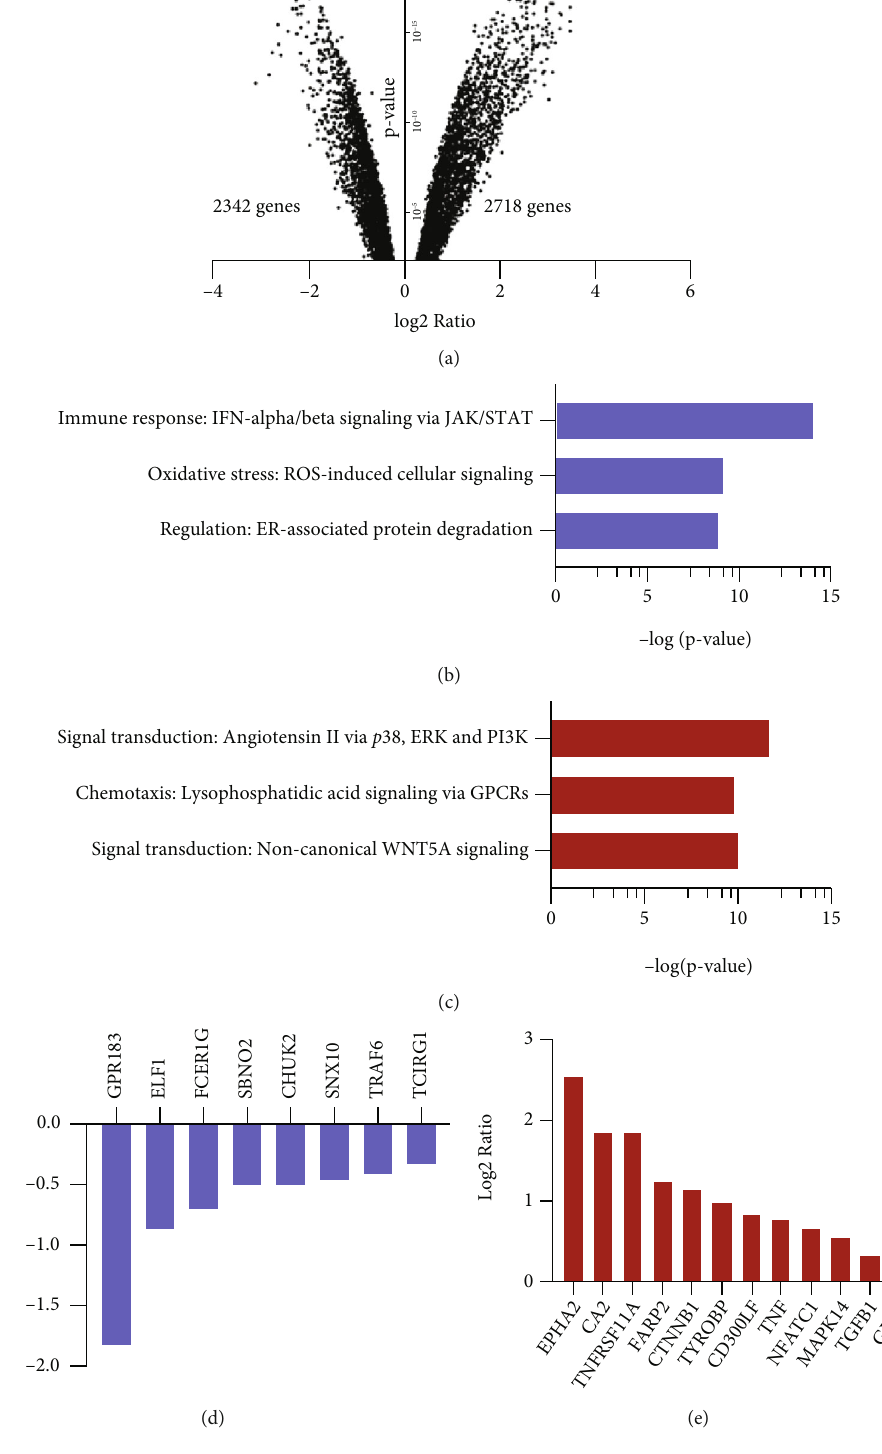
Figure 2: Butyrate regulates pathways and expression of genes relevant for bone healing and osteoclast di ff erentiation. RNA sequencing of human osteoclast precursor cells following 6 h of butyrate treatment. (a) Volcano plot showing number of upregulated and downregulated genes in osteoclast precursor cells following 6h stimulation with 0.5mM butyrate. Functional enrichment analysis showing the three most signi fi cantly downregulated (b) and upregulated (c) pathways following 6h of 0.5mM butyrate treatment. (d) Downregulation and (e) upregulation of genes involved in osteoclast di ff erentiation following 6h 0.5mM butyrate treatment. Fold change threshold = 0 : 5 and FDR threshold < 0 : 01 for all